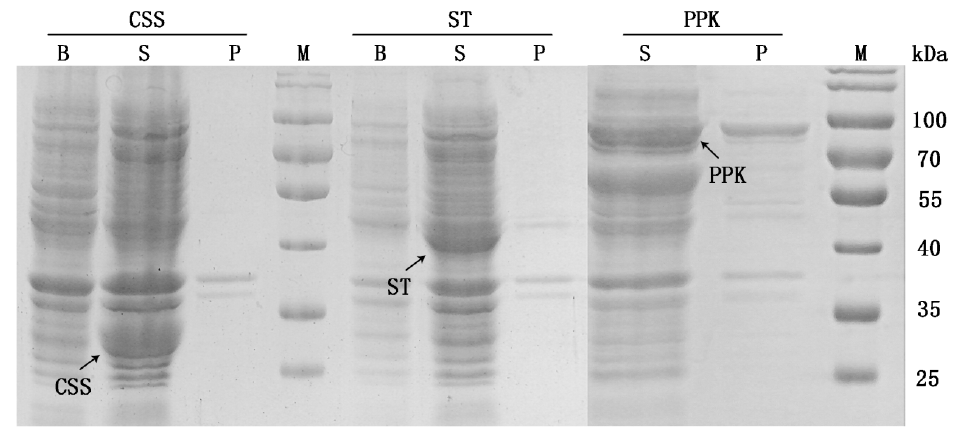
Figure 2. SDS-PAGE of the expressed proteins of CSS, ST, and PPK. Lane S denotes supernatant of the cell-extracts, lane P denotes precipitation fraction of the cell-extracts; lane B denotes cell lysate before induction; lane M shows molecular weight markers.